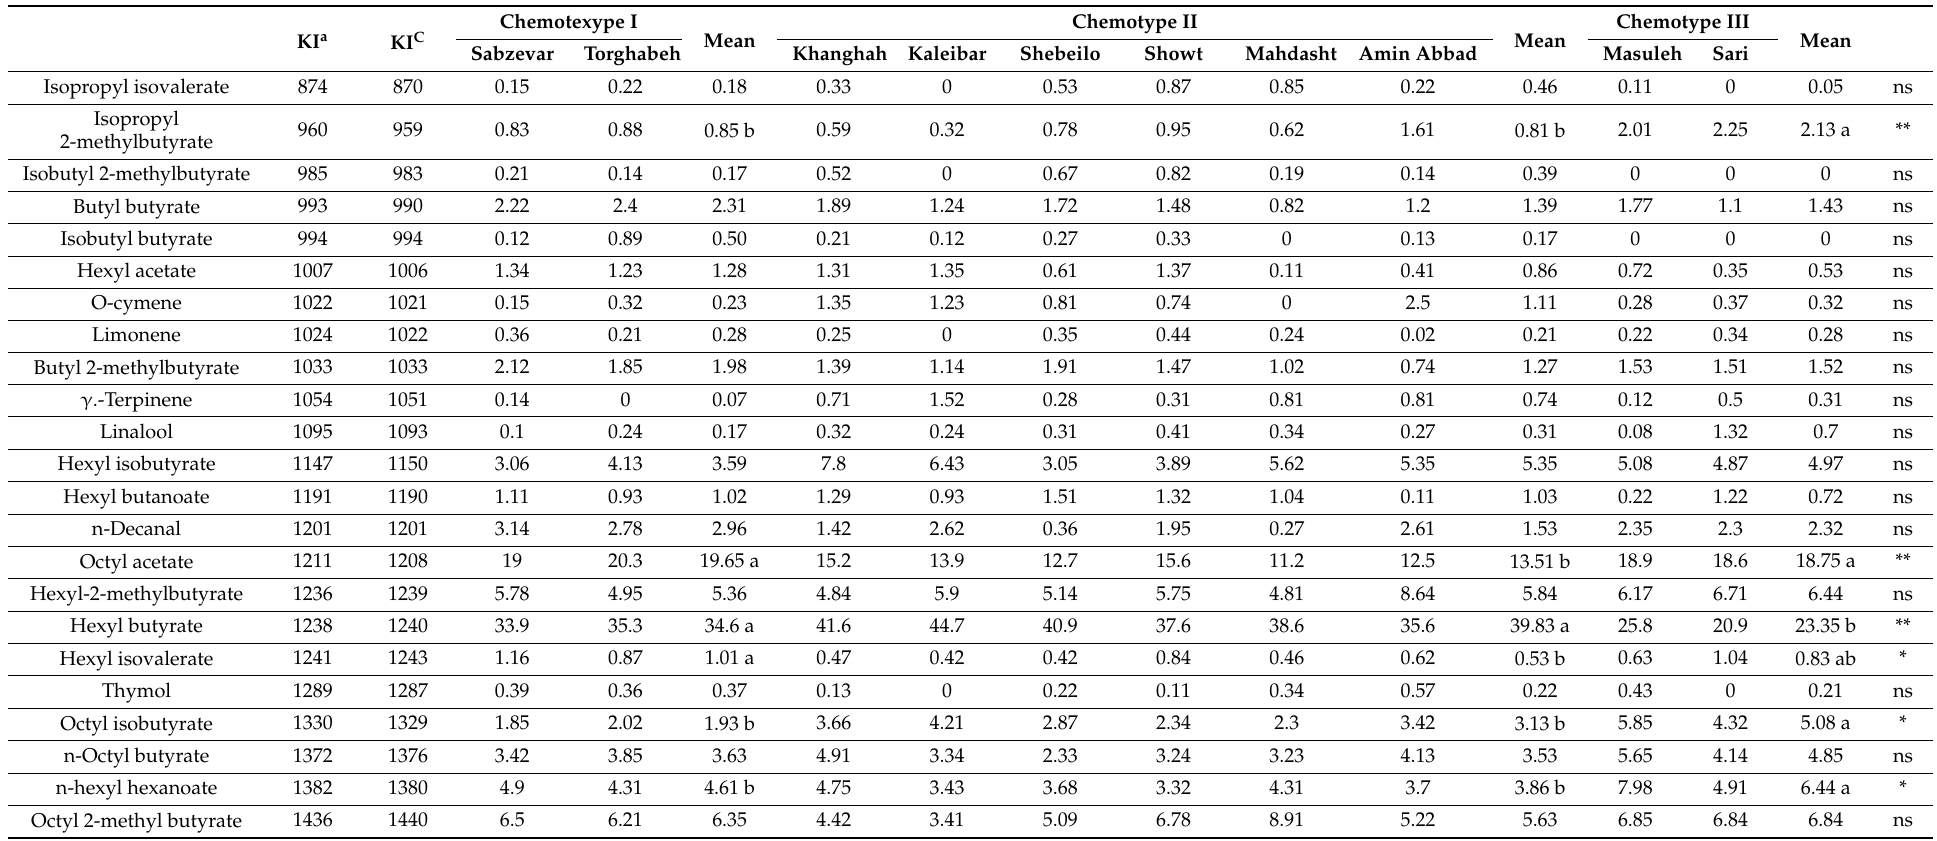
Table 1. The EO composition of the populations of H. persicum